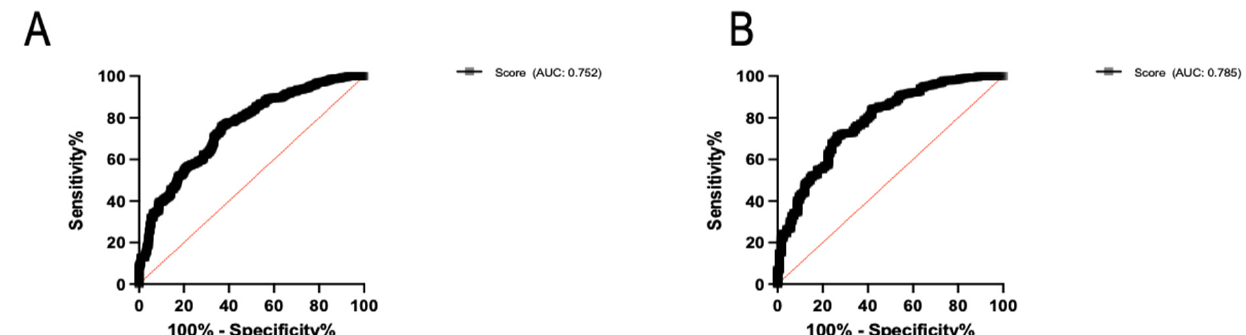
Figure 5. ( A ). Receiver operating characteristic (ROC) curve analysis of seroconversion (defined by an antibody titer > 7.1 BAU/mL) after two vaccine doses according to the predictive scoring system. The area under curve (AUC) for the score was 0.752 ( p < 0.0001). ( B ). ROC curve analysis of good response (defined by an antibody titer ≥ 143 BAU/mL) after two vaccine doses according to the predictive scoring system. The area under curve (AUC) for the score was 0.785 ( p < 0.0001).